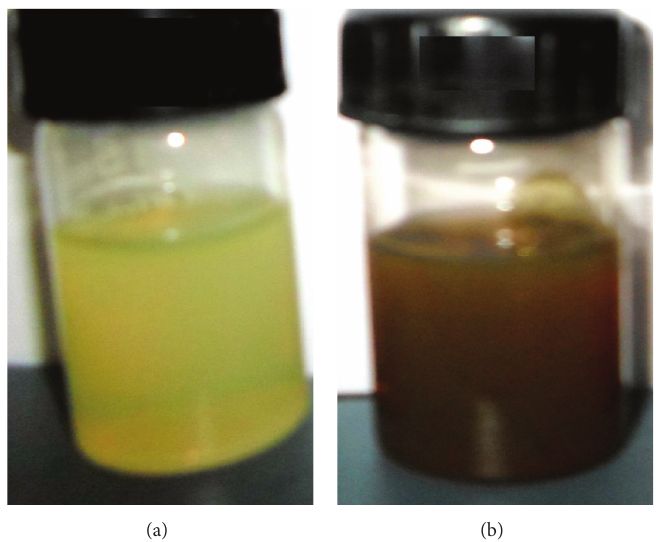
Figure 1: Biosynthesis of silver nanoparticles (a) and culture supernatant of Planomicrobium sp. (b) after the addition of AgNO 3 at 24 hrs incubation.